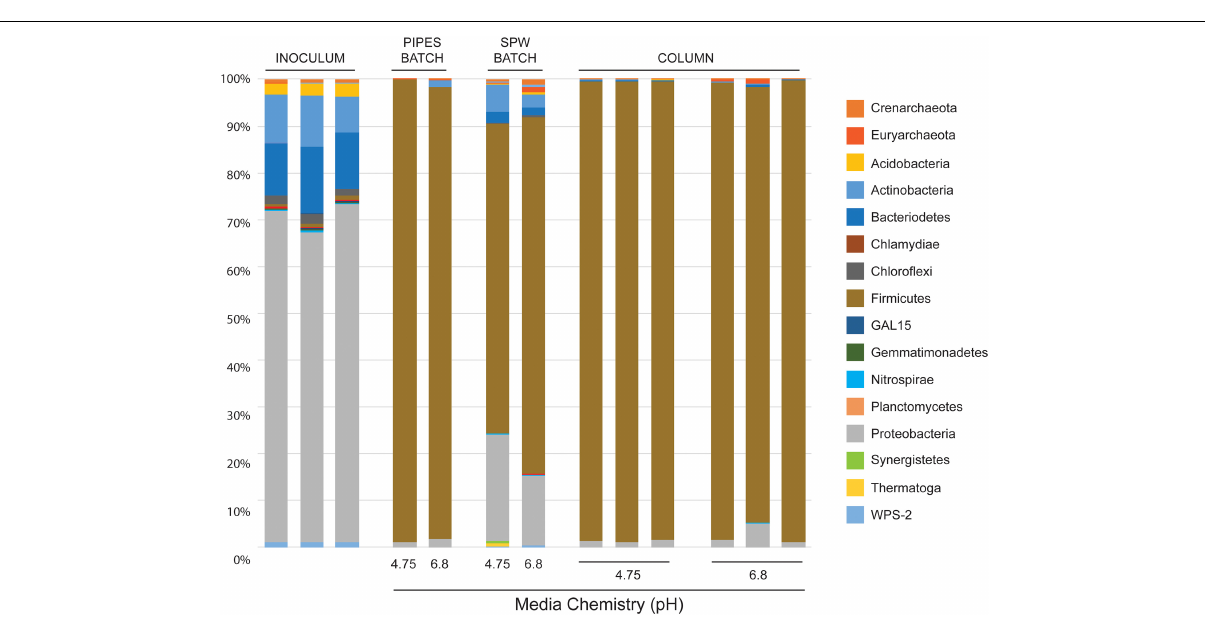
FIGURE 2 | Illumina sequencing results of phylum-level community diversity in batch and column cultures. Illumina sequencing of sub muros inoculated samples at day 0 are shown (inoculum). The diversity in our previous batch culture experiments, where the basal media was buffered with PIPES is shown (indicated as PIPES BATCH; Parker et al., 2018), followed by the cultures presented here using SPW with lactate (SPW BATCH). Illumina data is also provided for each of the individual columns in the flow-through experiments (COLUMN). The basal pH of each media formulation at day 0 is shown (Media Chemistry